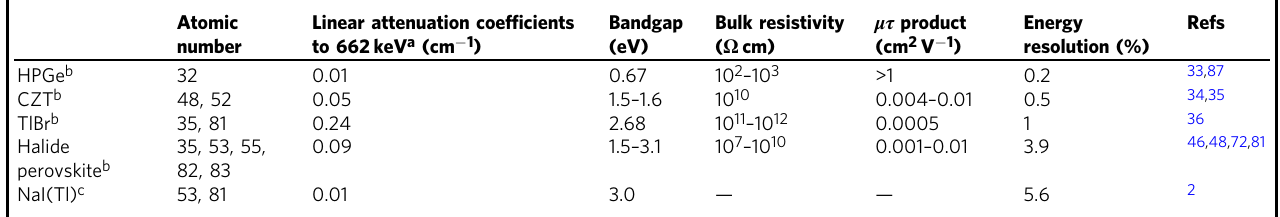
Table 2 Detailed γ -ray detector for energy spectrum Atomic number